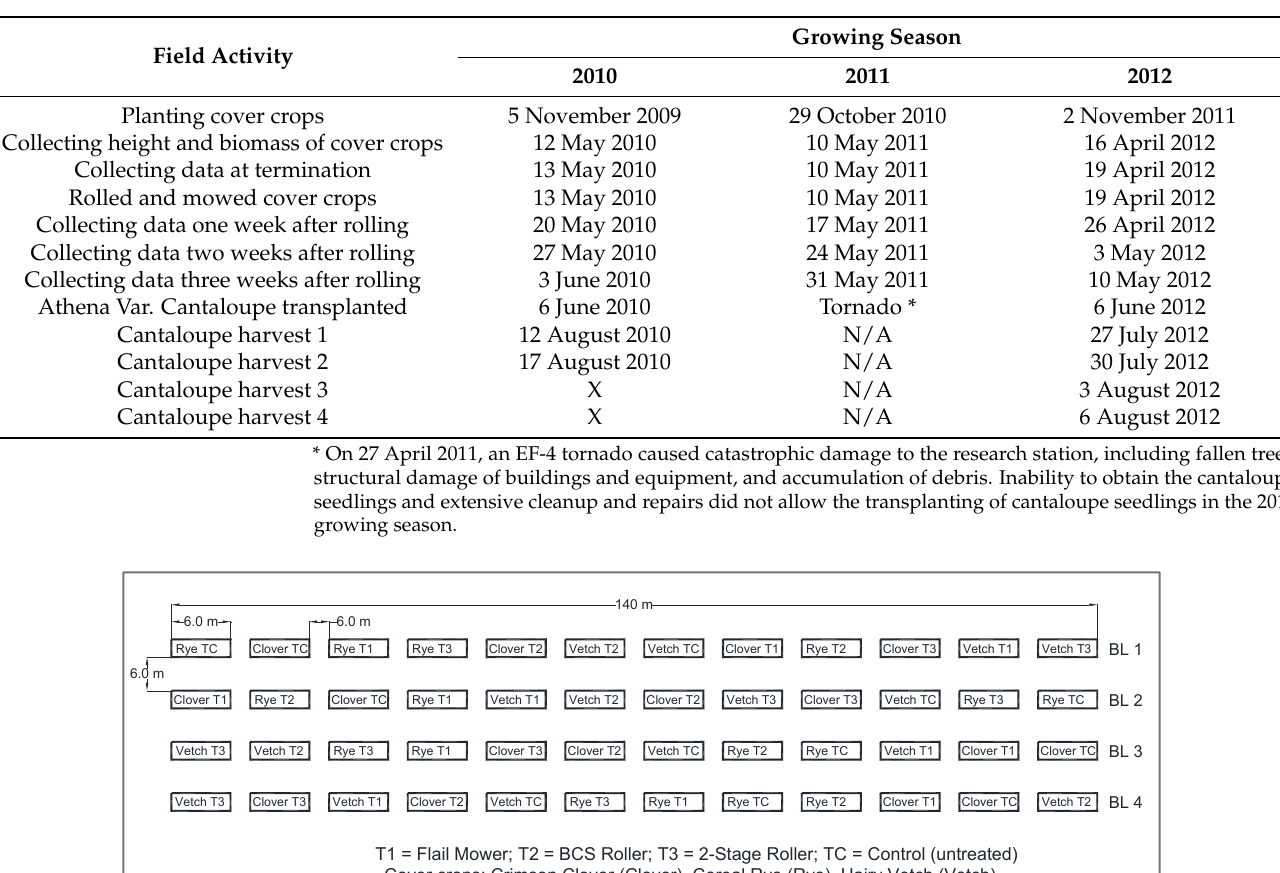
Figure 1. Experimental layout of the randomized complete block design to evaluate the effects of different management methods for selected cover crops on main crop cantaloupe yield (Athena variety, for which seedlings were obtained from Haynes Plant Farm in Cullman, AL, USA). Crimson clover, cereal rye, and hairy vetch were planted each fall (2009–2011) at a rate of 22 kg ha − 1 , 112 kg ha − 1 , and 22 kg ha − 1 , respectively, utilizing a Tye no-till drill from AGCO Corporation, Duluth, GA, USA (Figure 2).